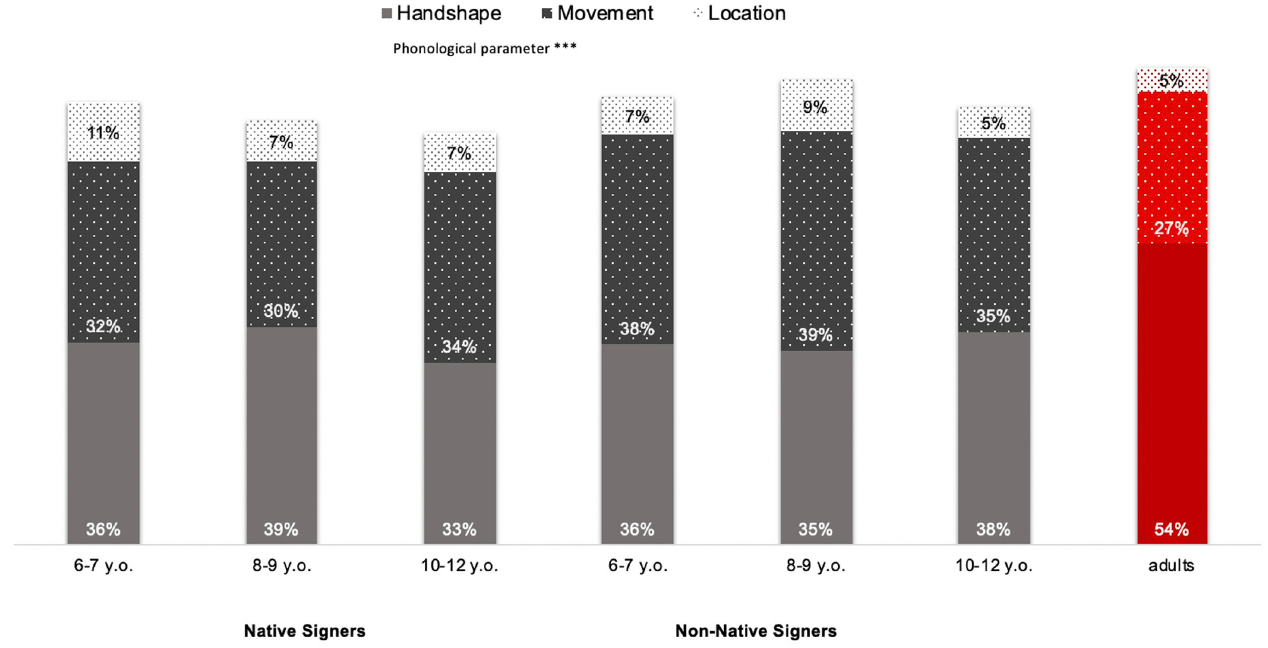
Fig 6. Proportion of phonological errors made deaf signing children according to age of acquisition, chronological age and type of manual parameter. Adults are considered as the control group ( ��� p < .001; �� p < .01; � p < .05; n.s. p > .05).